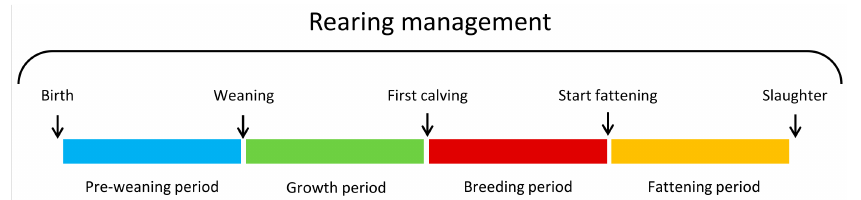
Figure 1. Description of the four key rearing periods during the cull cows’ whole